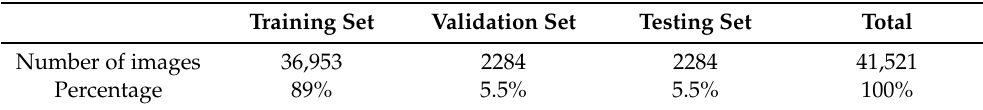
Table 3. Number and percentage of images in the training, validation, and testing sets of our car model classification dataset.